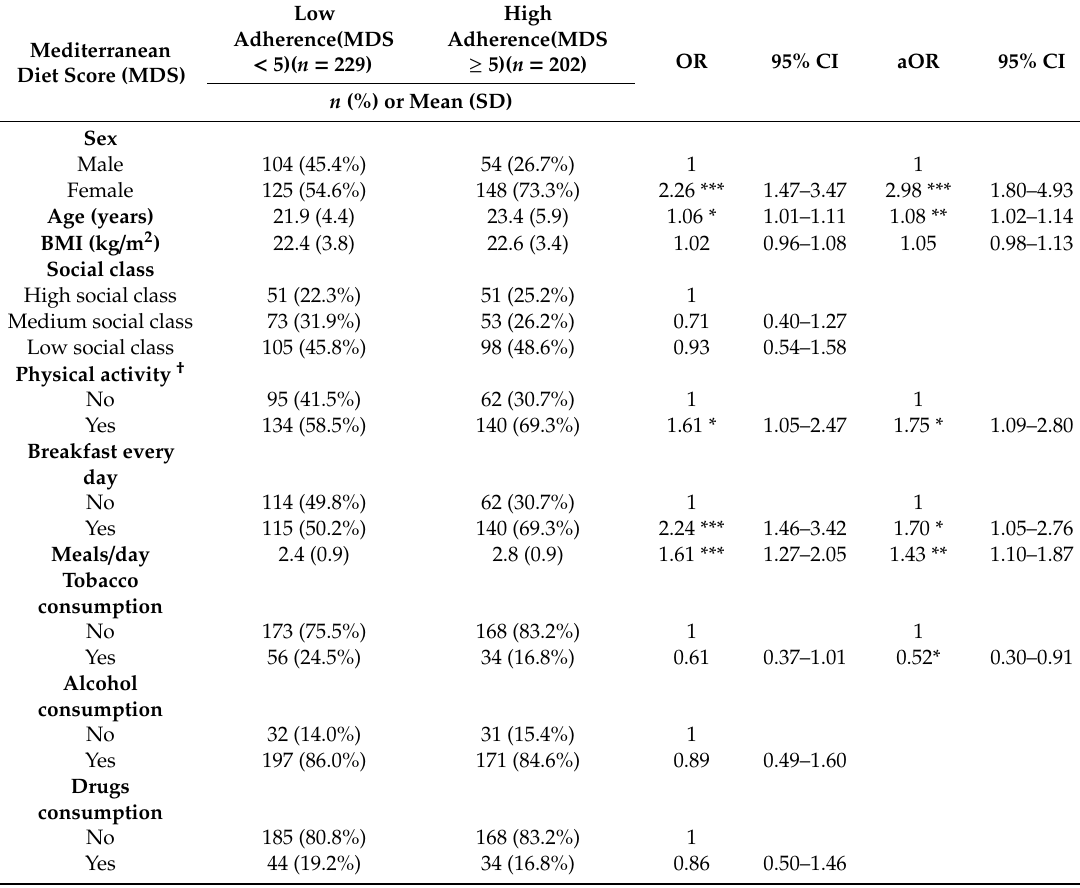
Table 4. Univariate and multivariate analysis of factors associated with adherence to the Mediterranean diet ( n =